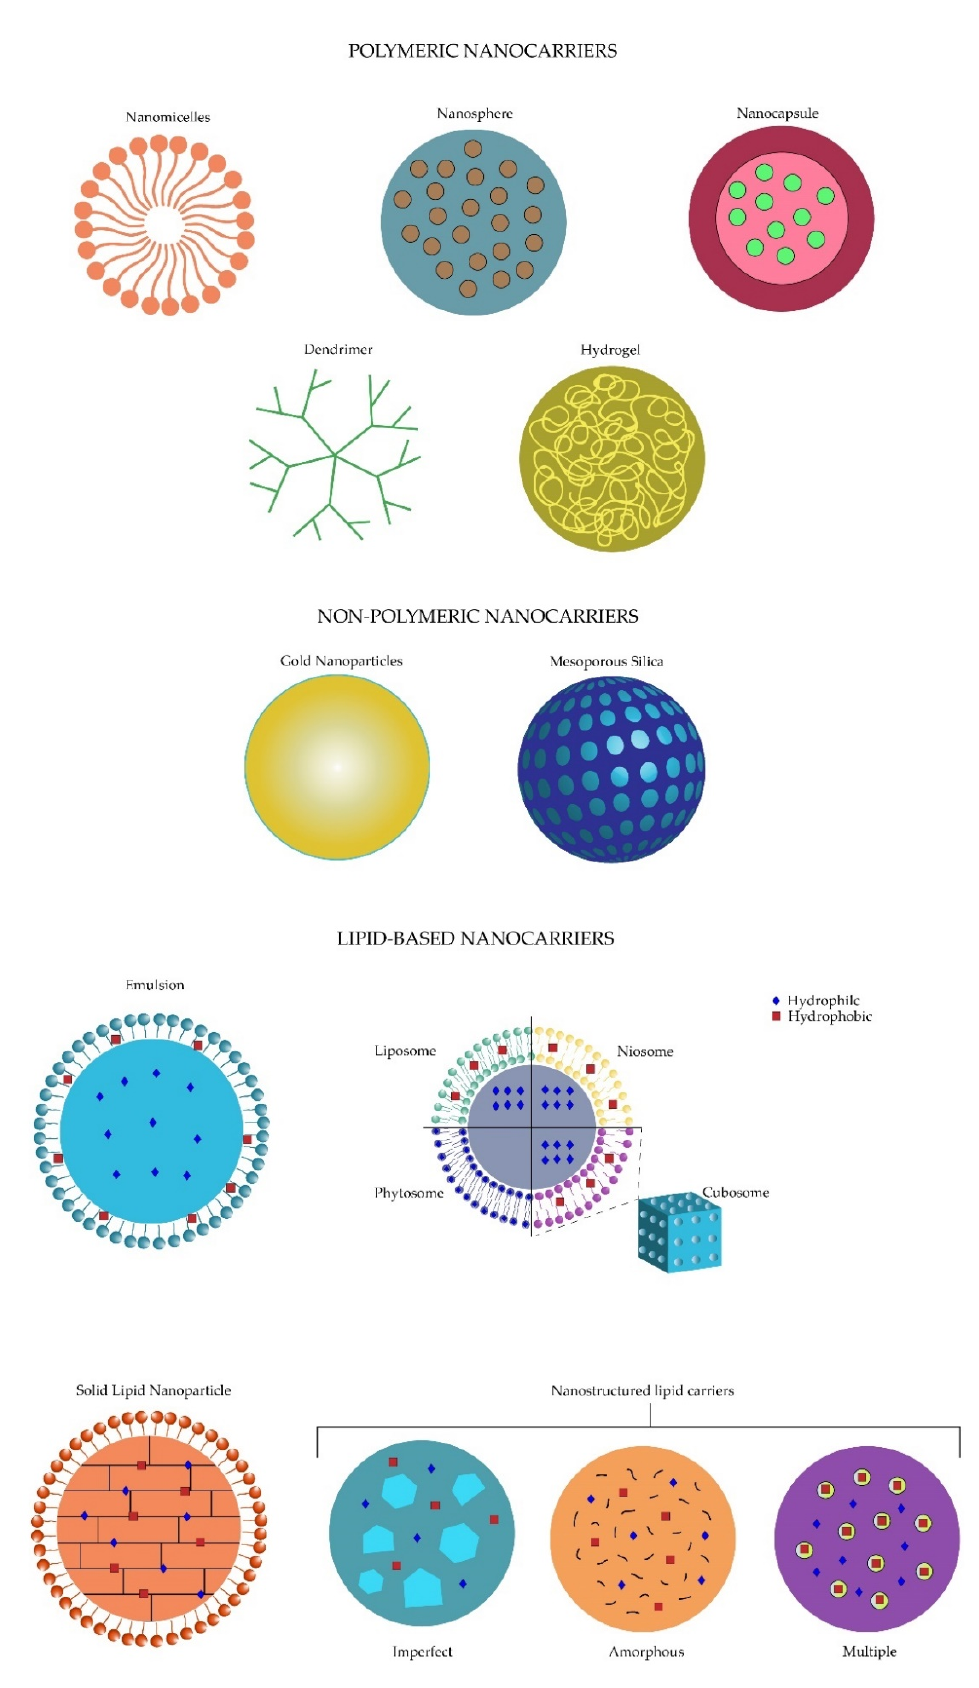
Figure 4. Structure of the different topical nanosystems.